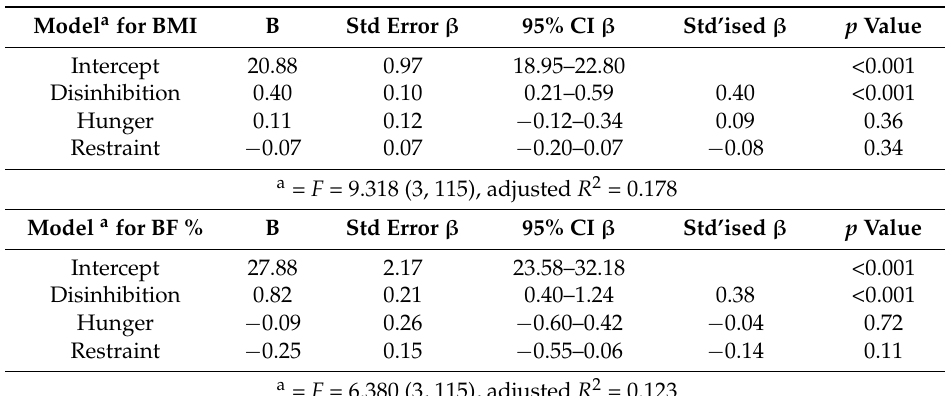
Table 2. Multiple Linear Regression of TFEQ factors correlation to body mass index (BMI) and body fat percentage (BF %).